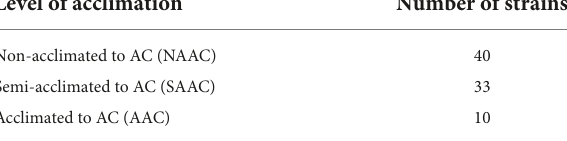
TABLE 2 Classification of 83 C. jejuni isolates submitted to gradual acclimation to aerobic conditions (AC). Level of